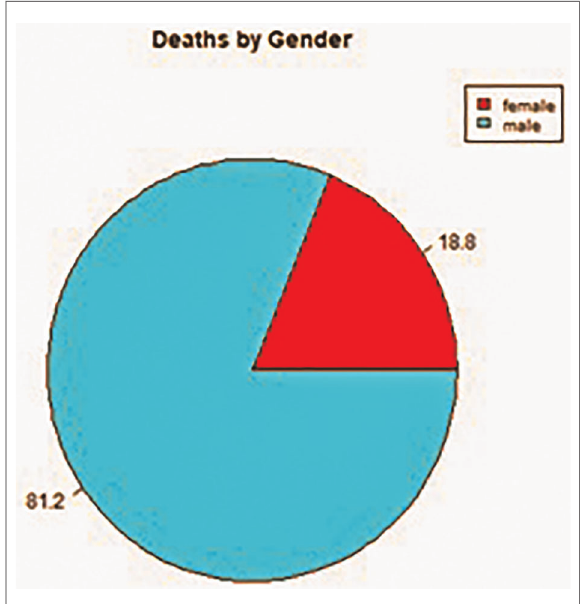
FIGURE 4 Age-group breakdown of deaths by suicide during the period 2008 – 2017 in County